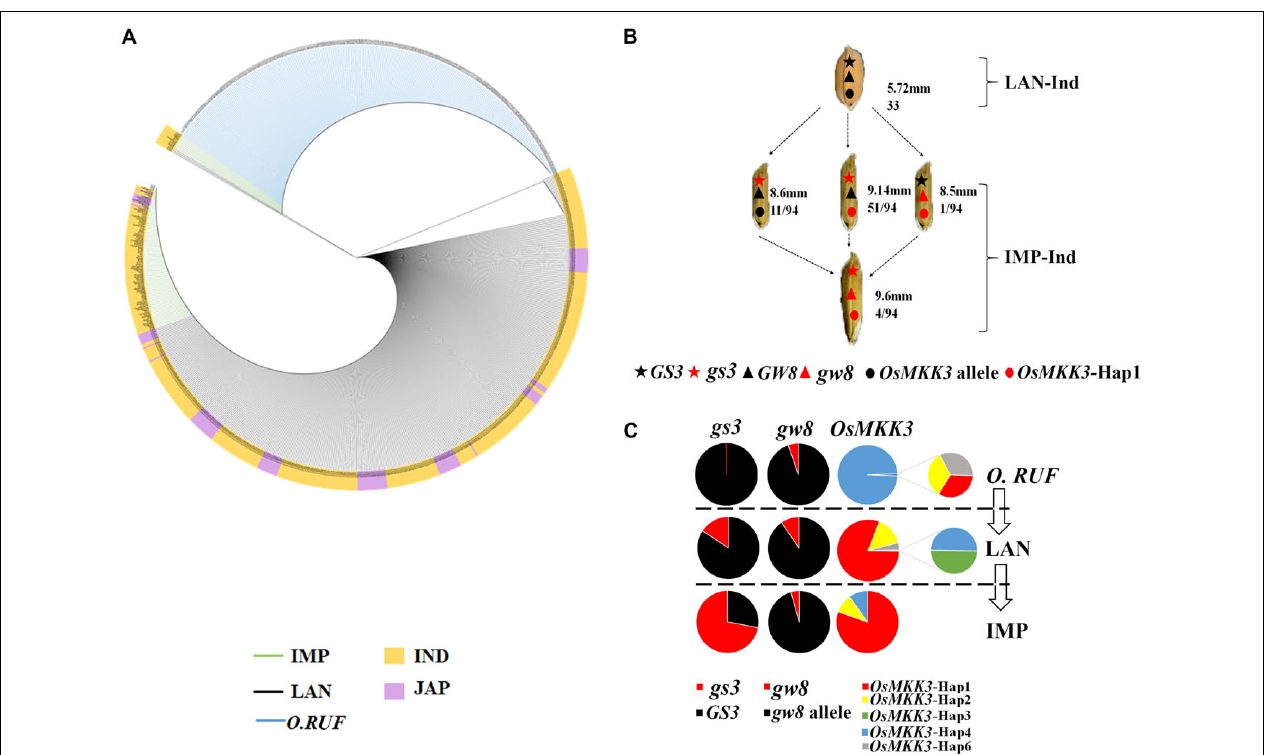
FIGURE 6 | Breeding improvement of OsMKK3 . (A) Phylogenetic analysis of haplotypes of OsMKK3 in wild rice accessions, Guangxi core germplasm landrace accessions, and improved varieties. The phylogenetic tree of varieties was constructed based on different functional SNPs in OsMKK3 CDS by MAGE 7.0. The blue line corresponds to wild rice, the black line corresponds to landraces, and the green line corresponds to improved varieties. (B) Improvement of the haplotype combination for three grain length-related genes, as in (A) . Top numbers indicate average grain length; bottom numbers correspond to the accession number of a certain haplotype combination in the subgroup. (C) Spectra of allele frequencies comparing landrace and improved varieties at the causal polymorphisms of GS3 , GW8 , and OsMKK3 during modern breeding in the respective subgroups. LAN landraces, IMP improved